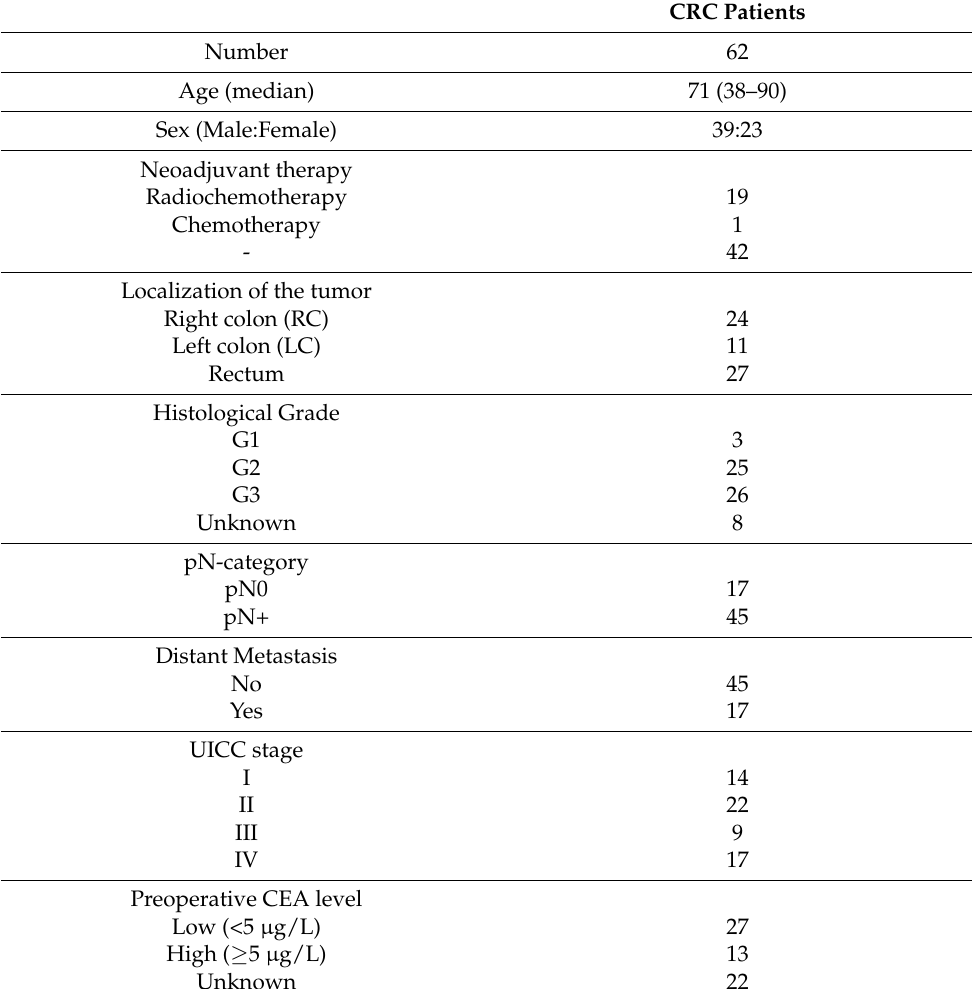
Table 3. Characteristic features of the study